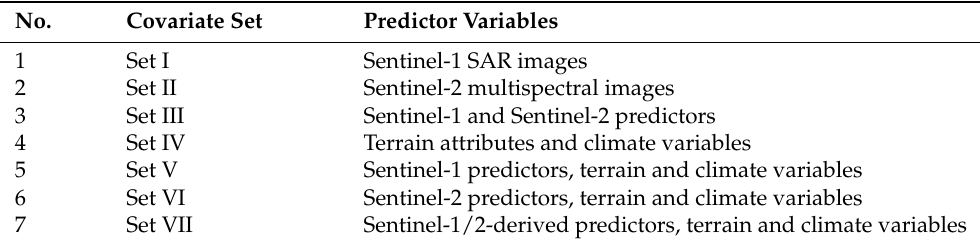
Table 2. Different combinations of environmental covariates used as model inputs for SOC prediction.